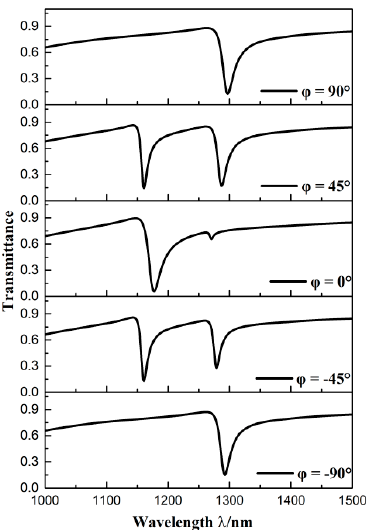
Figure 3. Transmission spectra of structures with diverse angle between horizontal axis and centerline of the stub on CRCS.